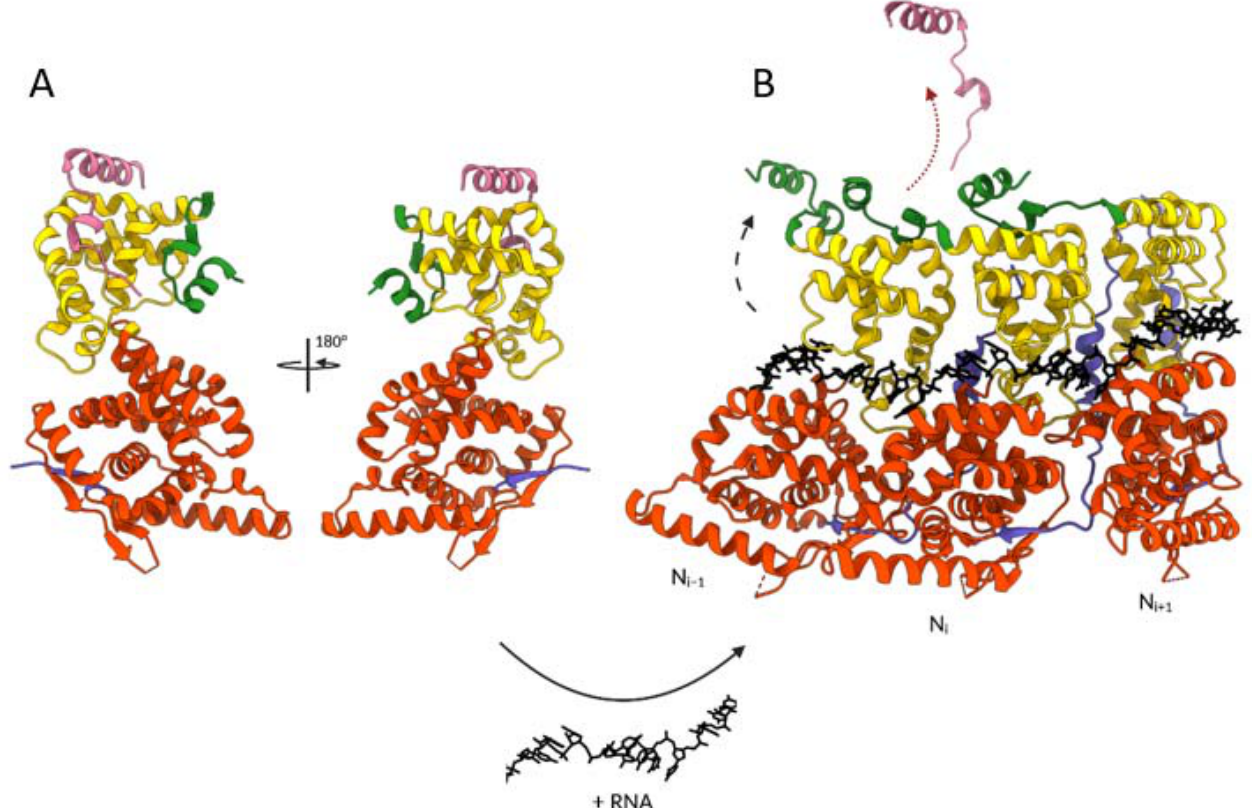
Figure 7. Structural changes involved in the transition from hMPV N 0 -P to oligomeric N-RNA forms. The transition requires the presence of RNA, as indicated at the bottom of the figure. ( A ) Crystal structure of hMPV N 0 - P 1-28 peptide complex (PDB: 5FVD). ( B ) Representation of a trimer of N in cartoon representation bound to RNA shown in black sticks (PDB: 5FVC). The black and red arrows symbolize the movement of the N C-arm and the release of P 1–28 peptide, respectively, required for N oligomerization. One N subunit is colored with the N NTD in orange, N CTD in yellow, and the N- and C-terminal parts in blue and green, respectively. The P 1-28 peptide is in pink. The N- and C-terminal extremities of N and the P peptide are indicated. Created with BioRender.com and UCSF ChimeraX [100].